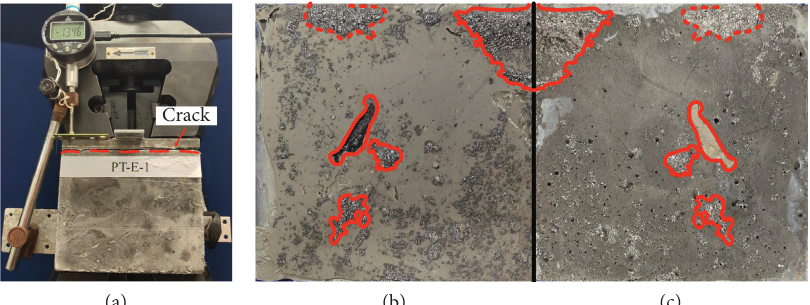
Figure 4: Cracking interface and failure interface of specimen PT-E during loading. (a) Cracking interface; (b) and (c) steel plate and UHPC